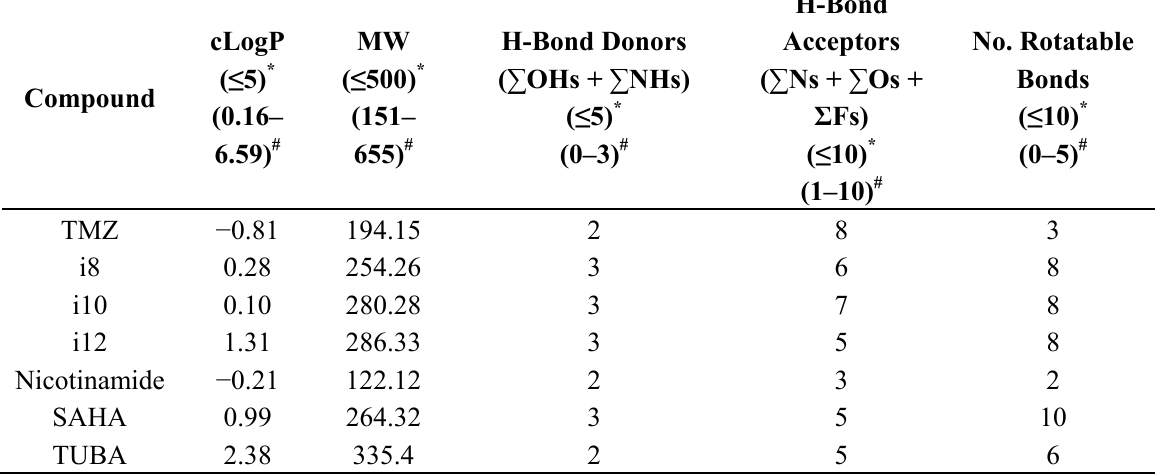
Table 1. Properties of the tested compounds in relation to the “rule of five” characterization of drugs [44]. Hydrophobicity is represented by the logarithm of the partition coefficient for n-octanol/water LogP (cLogP) calculated using ChemDraw Ultra 10.0 (cLogP). The allowed limits for a molecule to be considered as a drug are shown in brackets and indicated with *. The ranges observed for all known central nervous system drugs are indicated with # in the table. TMZ, temozolomide;